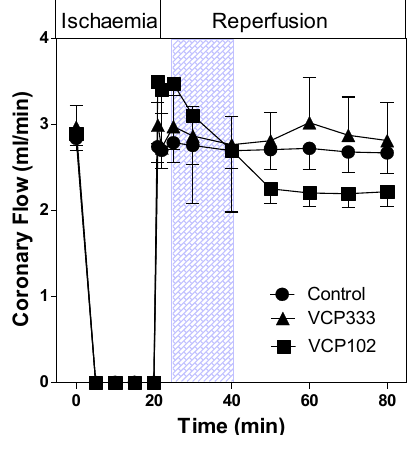
Figure 4. The effect of 15-min allosteric modulator VCP333 (1 μM) or VCP102 (10 μM) infusion on coronary flow (mL/min) in mouse isolated hearts following 20-min of global ischaemia. Values are mean ± SEM, n = 5–9 per